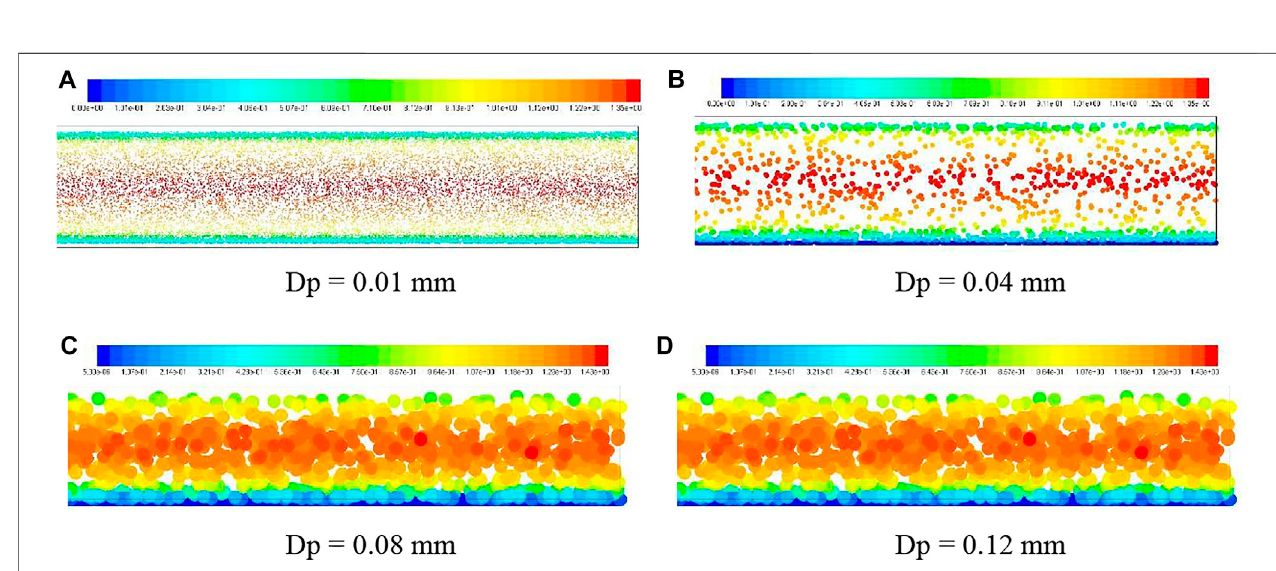
FIGURE 16 | Distributions of sediment particles at the outlet of the fracture. (A) Dp = 0.01 mm, (B) Dp = 0.04 mm, (C) Dp = 0.08 mm, (D) Dp = 0.12 mm.